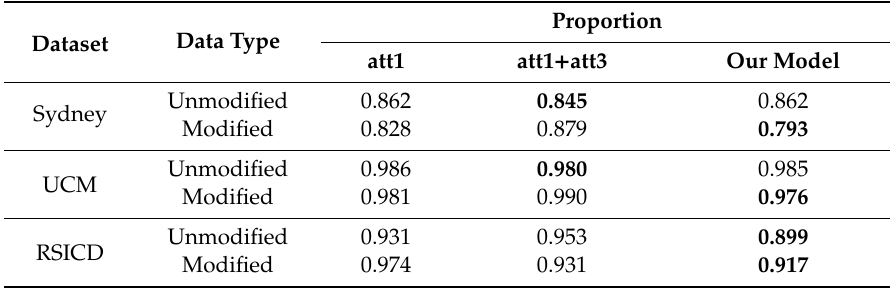
Table 6. The proportion of generated descriptions not in the training dataset of each model. The bold value is the lowest proportion.